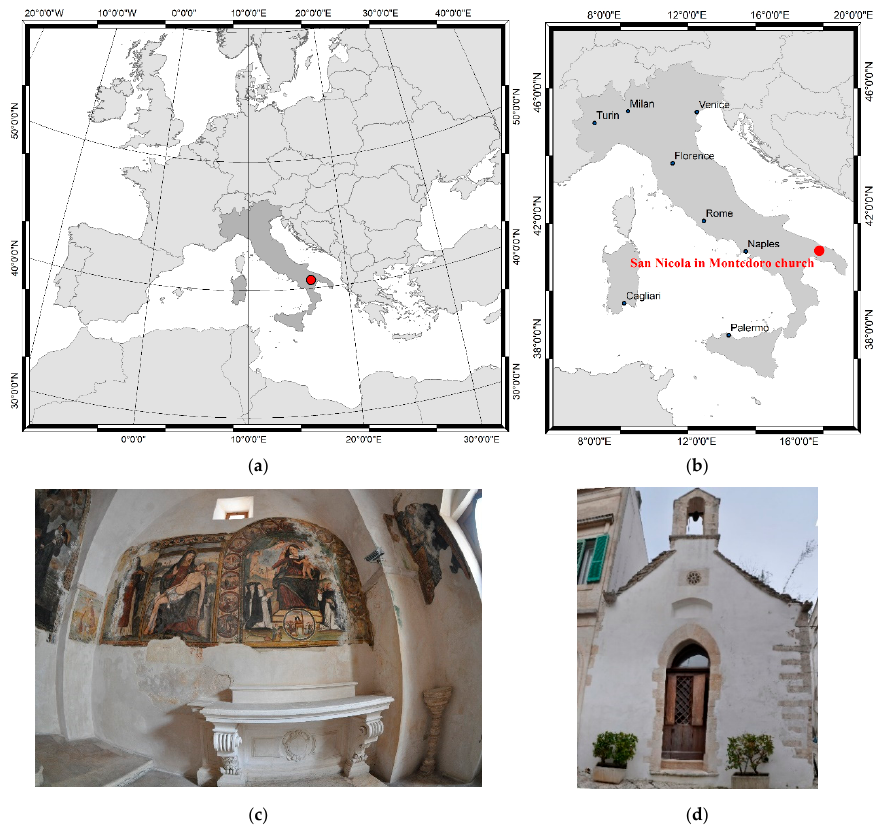
Figure 2. The church of San Nicola in Montedoro: location ( a , b ); image of the internal of the church acquired with fisheye lens ( c ); image of the external of the church ( d